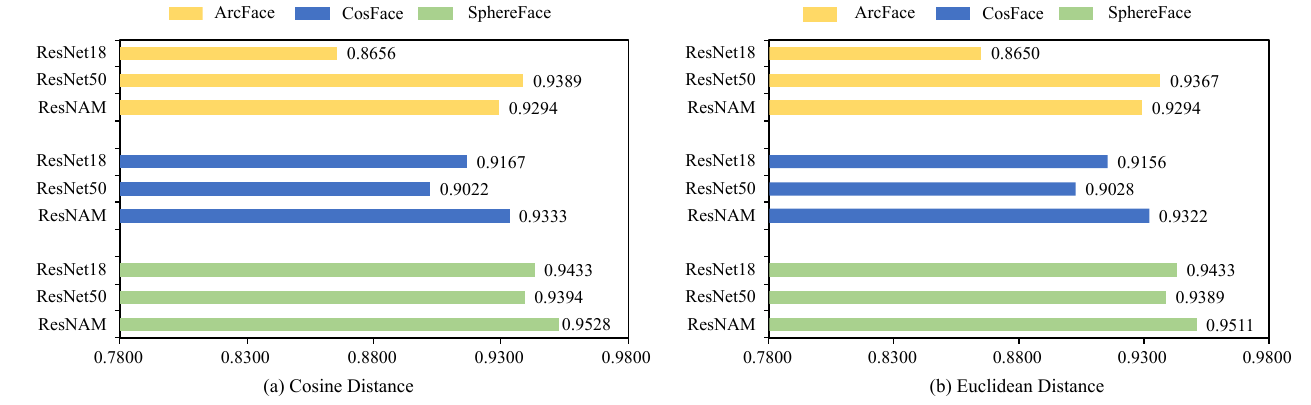
Figure 7. Structure of the backbone for pig facial image feature extraction. Table 2. Experimental results of the base